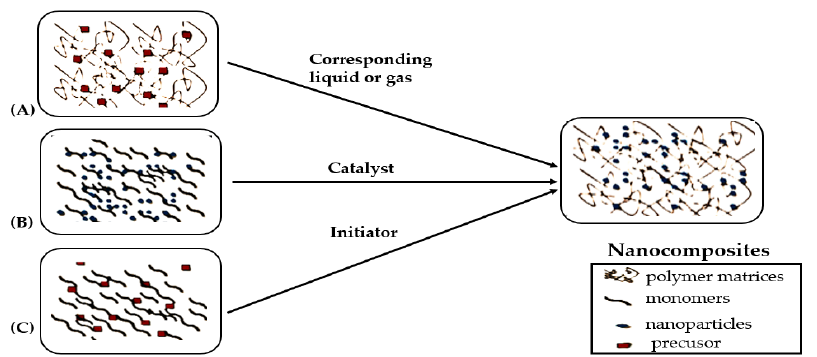
Figure 5. In situ polymerisation method. ( A ) the polymer was blended with metal ions as starting material, ( B ) Nanomaterial and the monomer were used as starting material, ( C ) Preparation of nanoparticles and polymer simultaneously